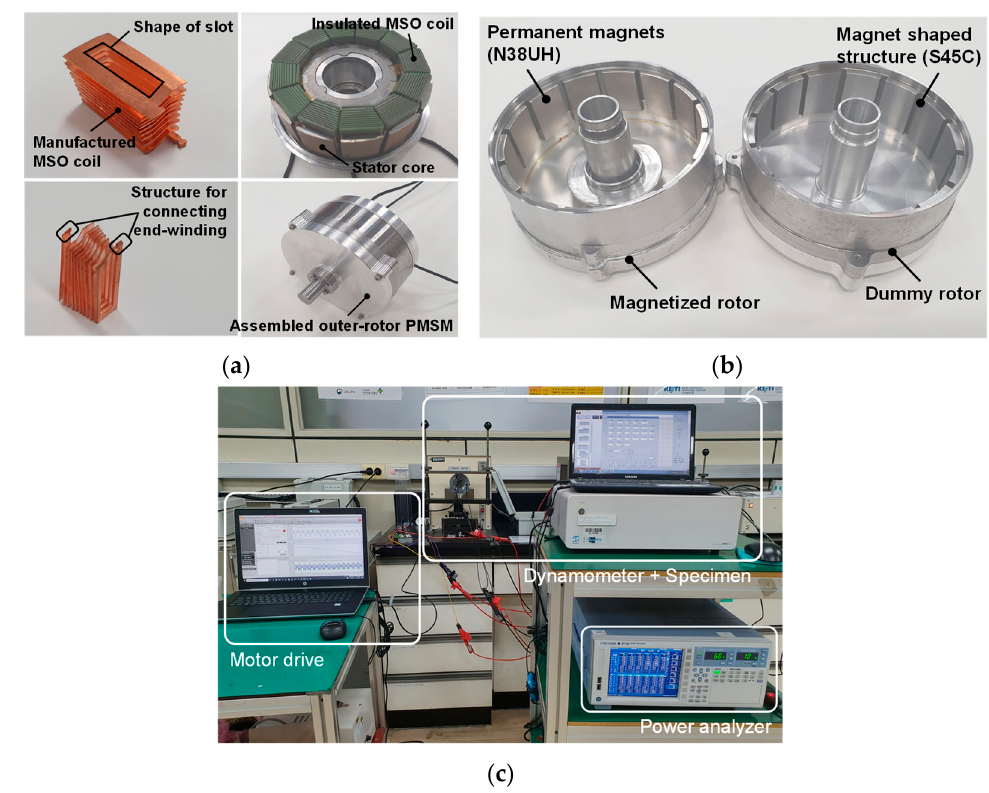
Figure 9. Specimen and experimental setup. ( a ) Manufactured specimen using MSO coil, ( b ) dummy rotor for measuring mechanical loss, and ( c ) experimental setup for verifying the